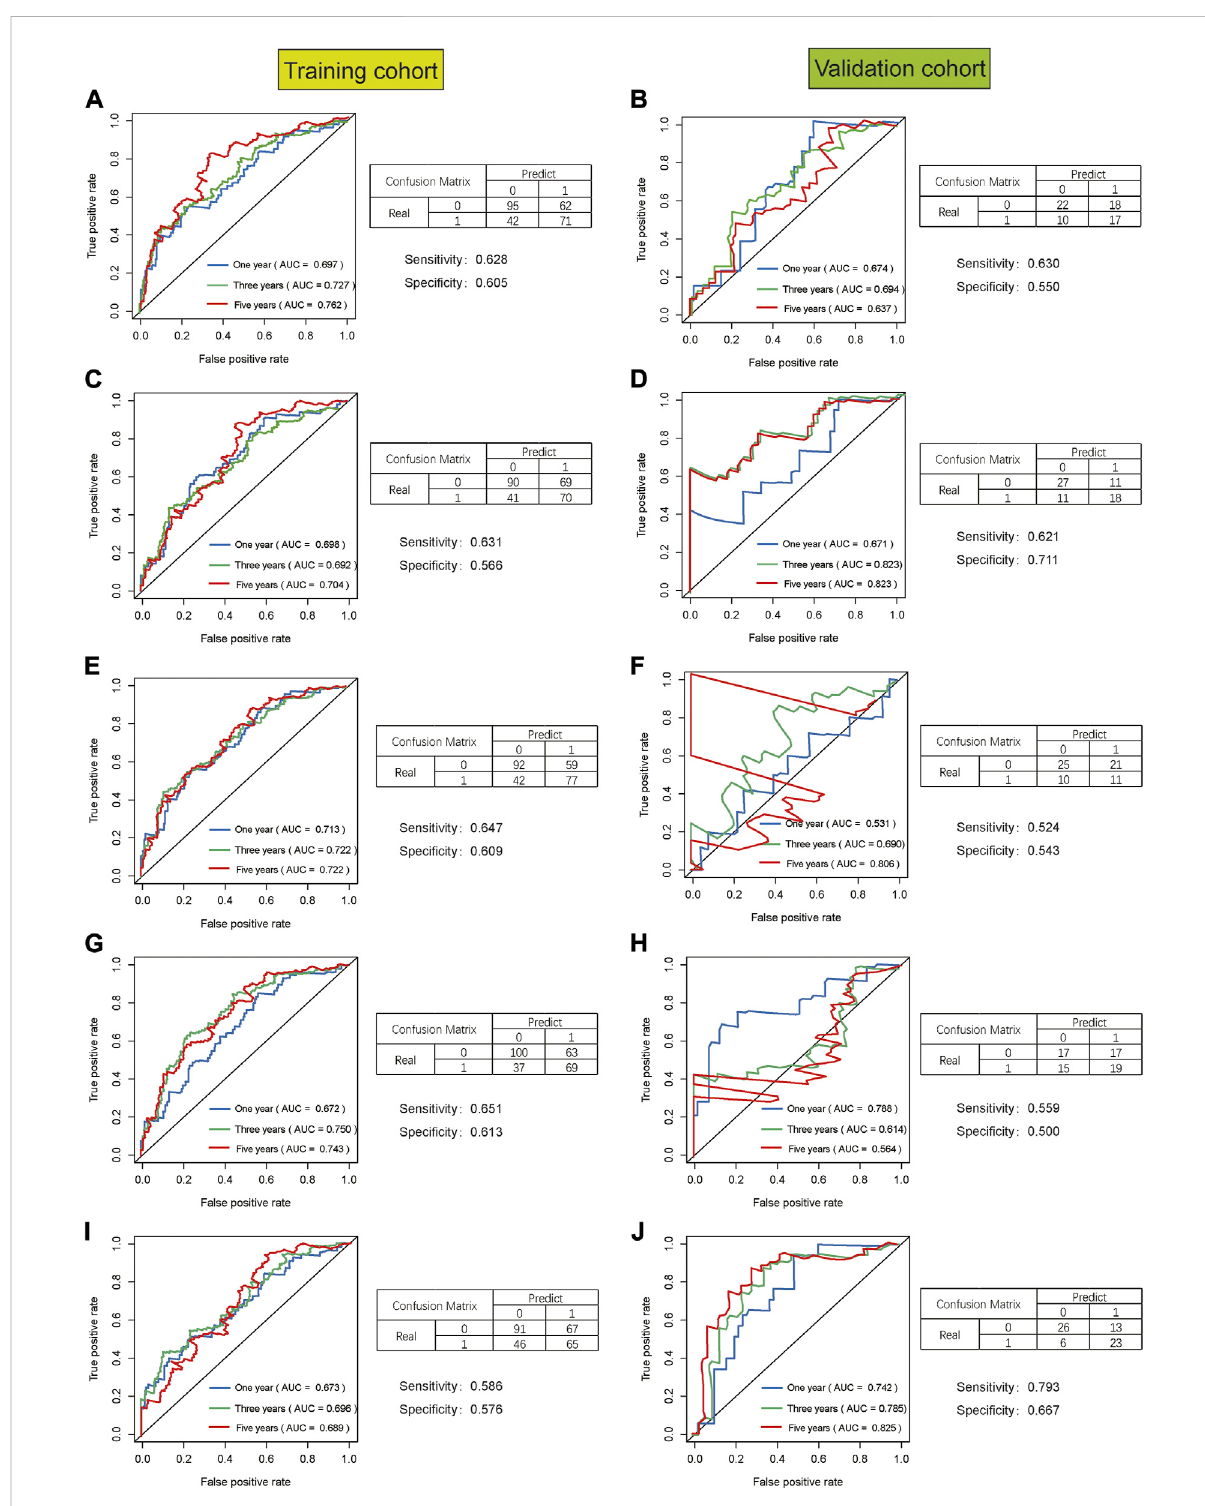
FIGURE 10 The result of 5-fold cross-validation based on seven glycolysis-related lncRNAs in STAD. AUC, confusion matrix, sensitivity and speci fi city were showed in each cross-validation cohort, results of training cohort on the left and validation cohort on the right in fi gure. (A,B) , (C,D) , (E,F) , (G,H) , (I,J) are the results from the fi rst cross-validation to the fi fth